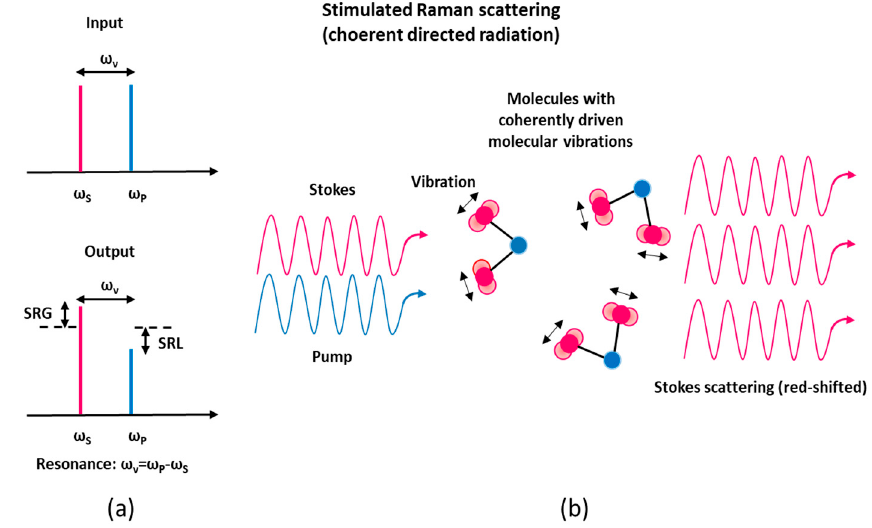
Figure 1. Stimulated Raman-Scattering (SRS) principle. ( a ) Pump–probe modalities associated with the SRS process are pointed out: SRG, stimulated Raman gain; SRL, stimulated Raman loss. ( b ) Stimulated Raman scattering occurs through inelastic scattering of probe photons off from vibrationally excited molecules that interfere coherently.